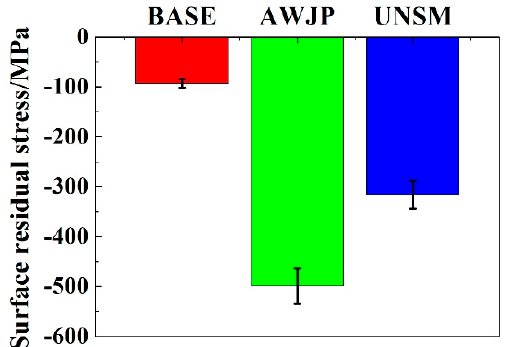
Figure 7. Surface residual stress of the 304 stainless steel BASE, AWJP, and UNSM specimens.